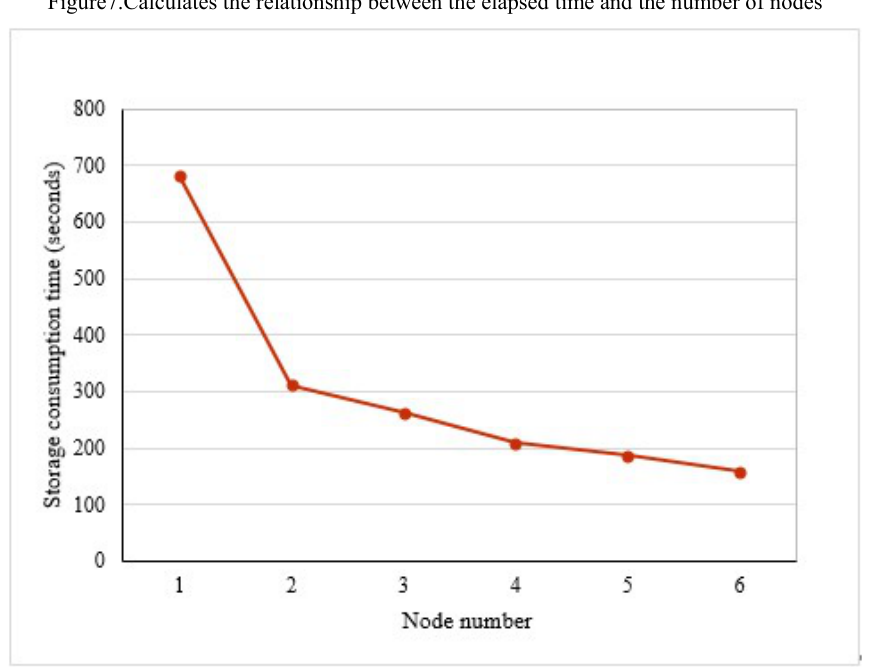
Figure 8 The relationship between storage consumption time and number of